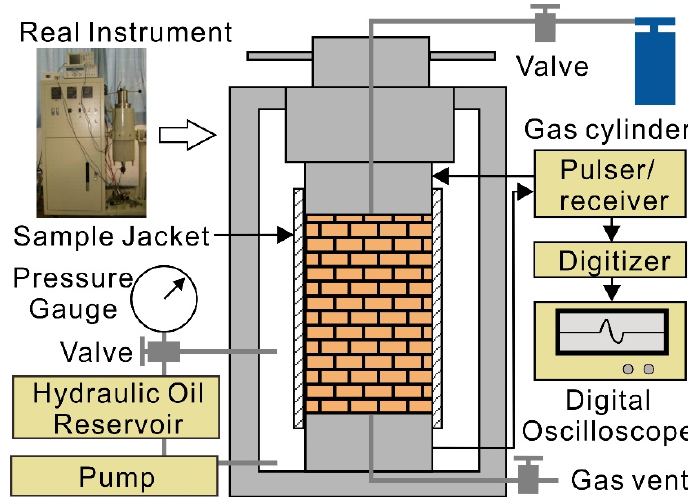
Figure 6. Scheme of the wave velocity measurement system. The system is mainly composed of three parts that provide confining pressure, porosity measurement, and pulse transmission measurement, respectively.